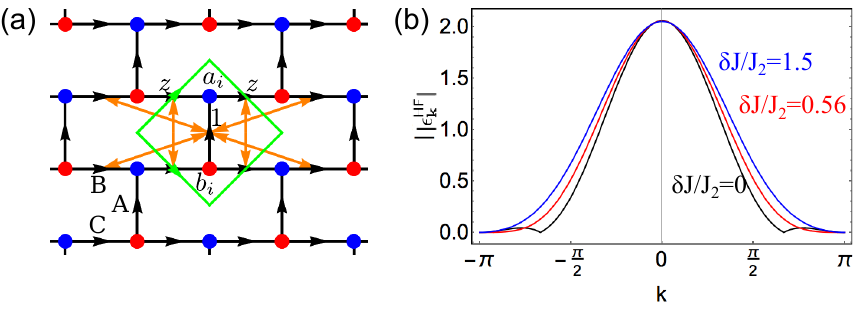
[ Eq. 85 ] used to pertur- Figure 25: The interacting brick lattice and Hartree-Fock spectrum ε HF k batively calculate Z hon2 [ Eq. 72 ] . (a) At first order in the perturbation expansion interactions occur between pairs of bonds that are on the same hexagon and separated by a single unfilled bond (shown [ a , b ] [ Eq. 76 ] . Higher-order terms in the action are in orange), resulting in a quartic interaction, S 4 associated with connected pairwise interactions, and thus involve 3 or more bonds (b) The spectrum ε HF [ Eq. 85 ] at the temperature for which ε HF ( T ) = 0 along the path k = ( k , k + π ) . For δ J / J = 1.5 ( π ,0 ) 2 k (blue) the minimum of the dispersion occurs at k = ( π ,0 ) , indicating a second-order phase transition. = 0 (black) there is an additional zero at k (cid:54) = ( π ,0 ) , indicating a break-down of the pertur- For δ J / J 2 bation theory and a first-order phase transition. The crossover between these two types of behaviour = 0.56 (red), which corresponds to a Pokrovsky-Talapov tricritical occurs at δ J / J 2